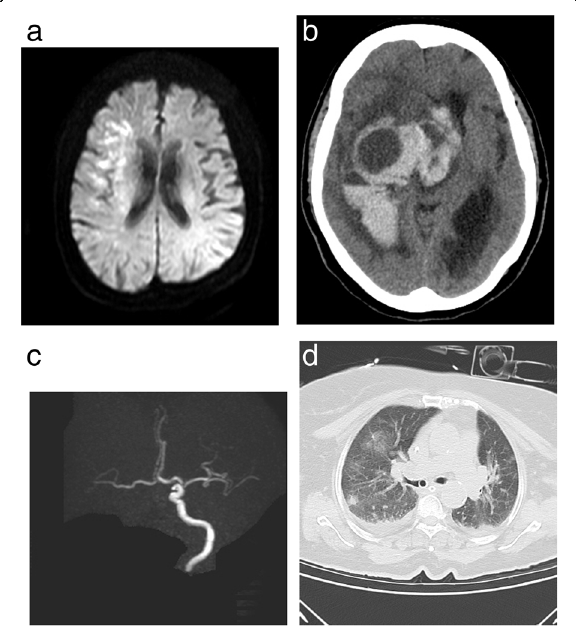
Fig. 1 Patient 8, a MRI DWI with right external watershed infarction, b complete occlusion of right internal carotid artery, c follow-up CT brain after sudden deterioration on day 12 showing hemorrhagic transformation, interventricular extension, and midline shift, d CT chest showed 2 small areas of ground glass appearance, mild right and minimal left-sided pleural effusion, low to intermediate left- sided pleural